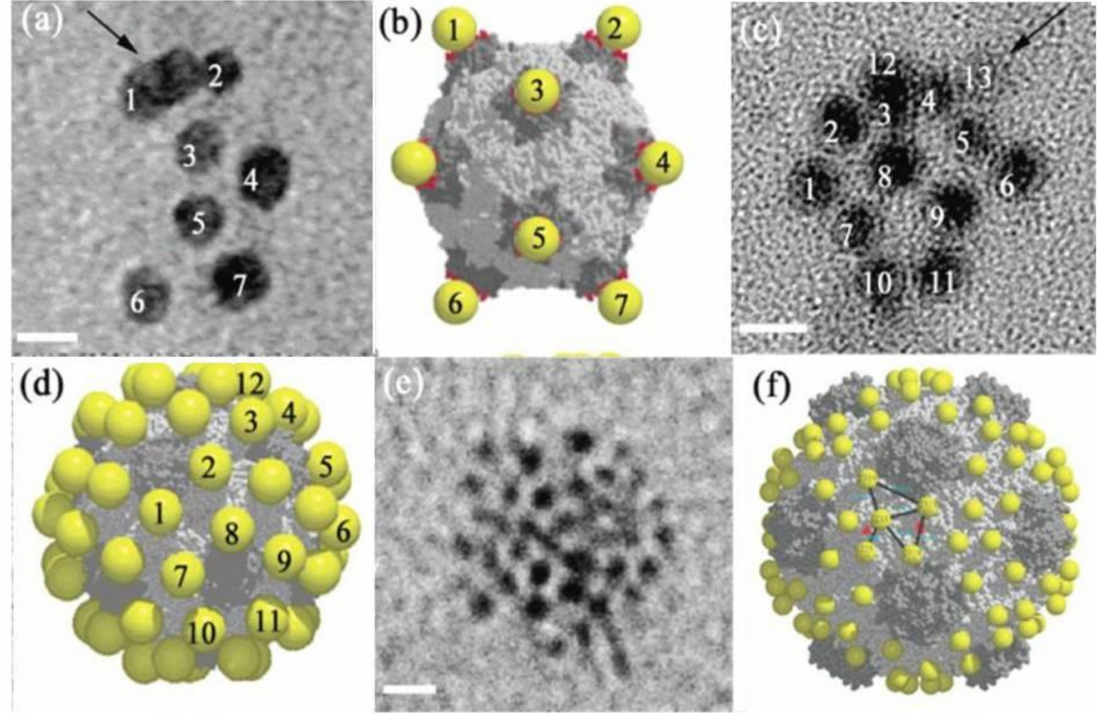
Figure 42. The Au NPs can be changed to the Cowpea Mosaic Virus (CPMV). ( a , c , e ) show untouched Au NP TEMs bound to various cysteine CPMV mutants with black circle au-NPs. The size of bars is 5 nm, with the Au NP models bound to modified sites ( b , d , f ) the CPMV models. Reprinted with reference authorisation [265], Copyright 2004,